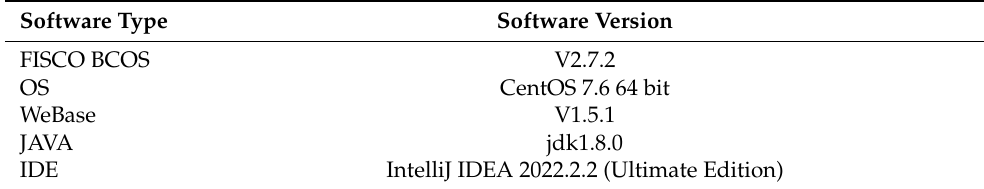
Table 7. Virtual machine software